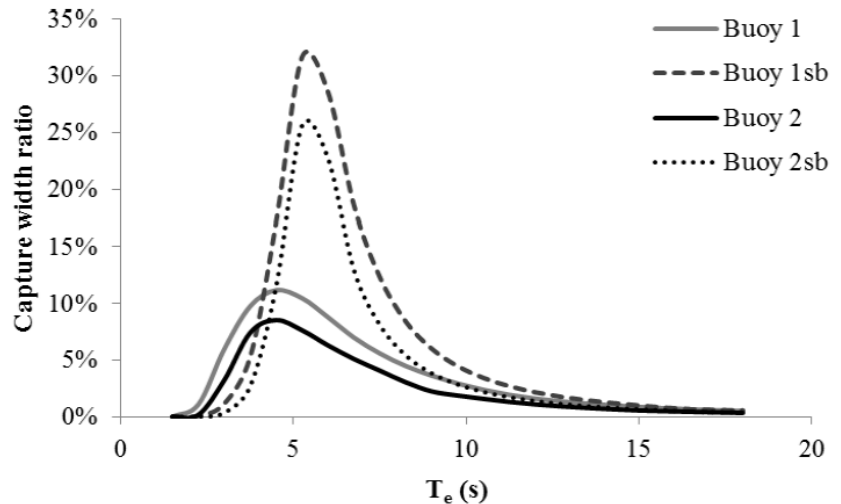
Figure 13. Power capture width ratio for different buoy dimensions with and without a submerged body, V S . the energy period T e , (the dotted lines are the two-body point absorbers) [12] .